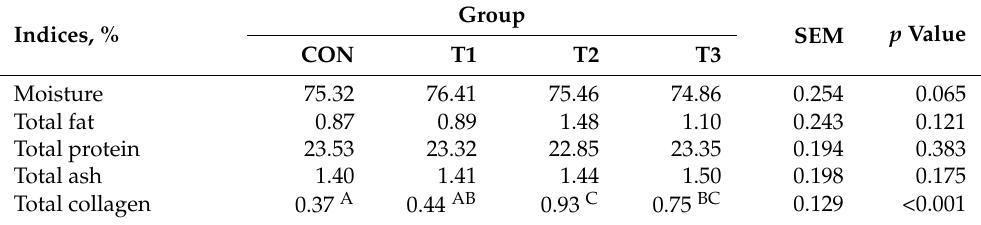
Table 3. Selected chemical components of breast muscles of male broiler chickens.